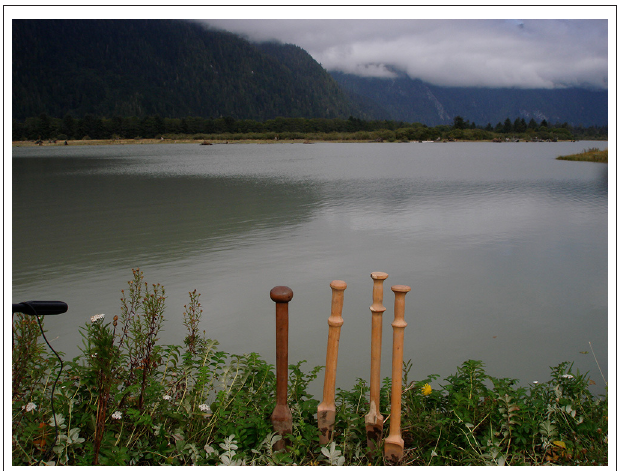
FIGURE 2 | Bog cranberries (top), with Pacific crabapples and a few wild rose hips.